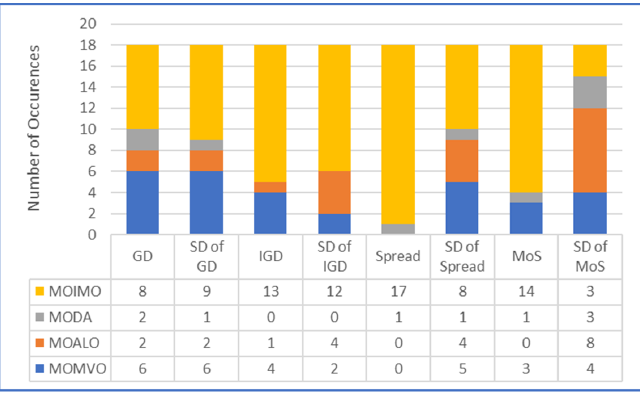
Fig. 5. Overall performance comparison of all the algorithms for benchmark test functions To sum up, the outcomes demonstrate that MOIMO is highly capable and modest compared to the existing well-regarded approaches. High coverage and convergence can be two key reasons behind it. Higher convergence is the result of